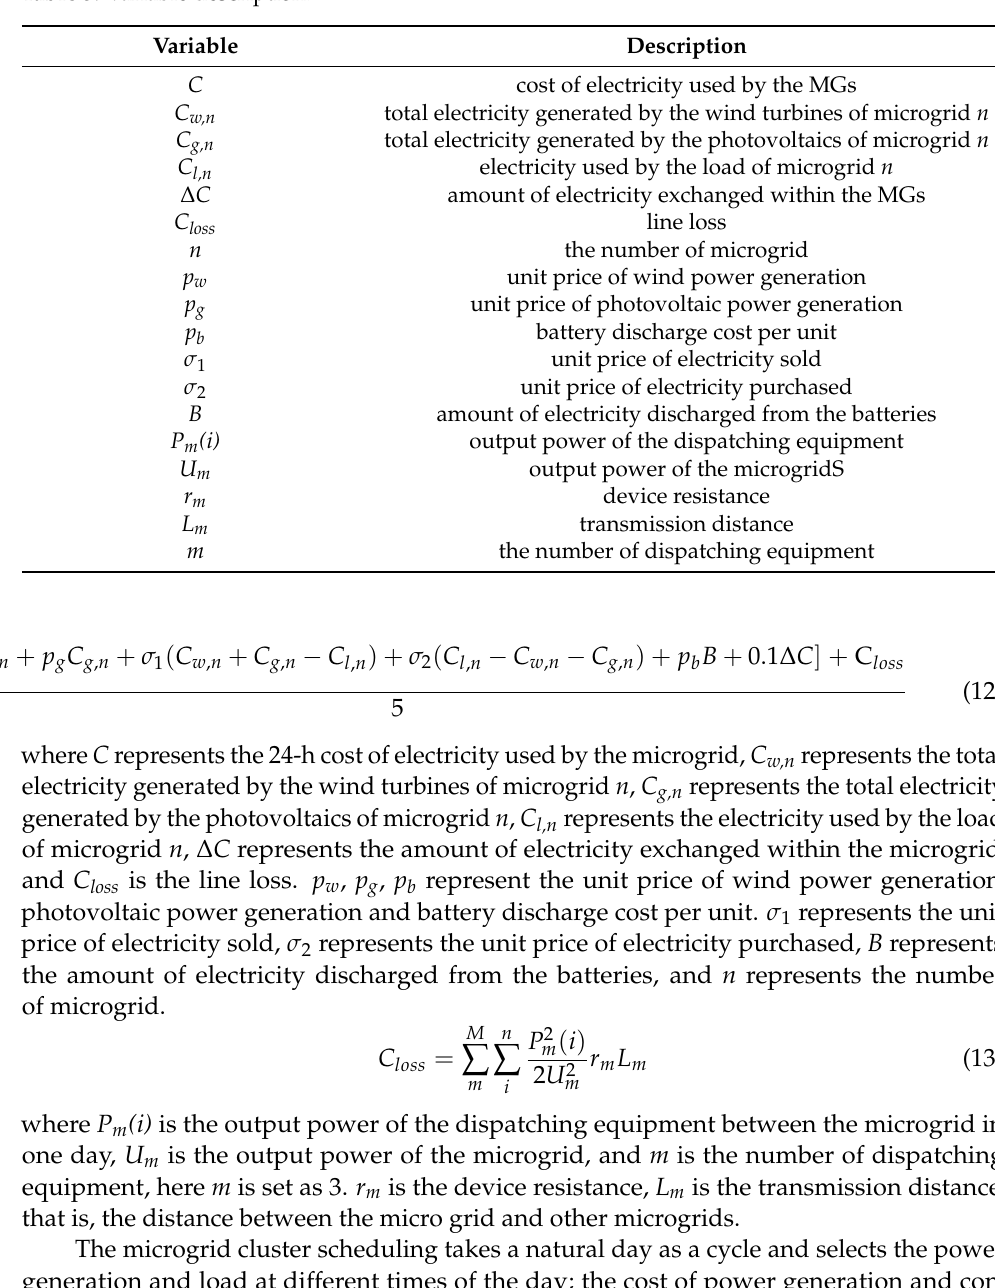
Table 5. Variable description.